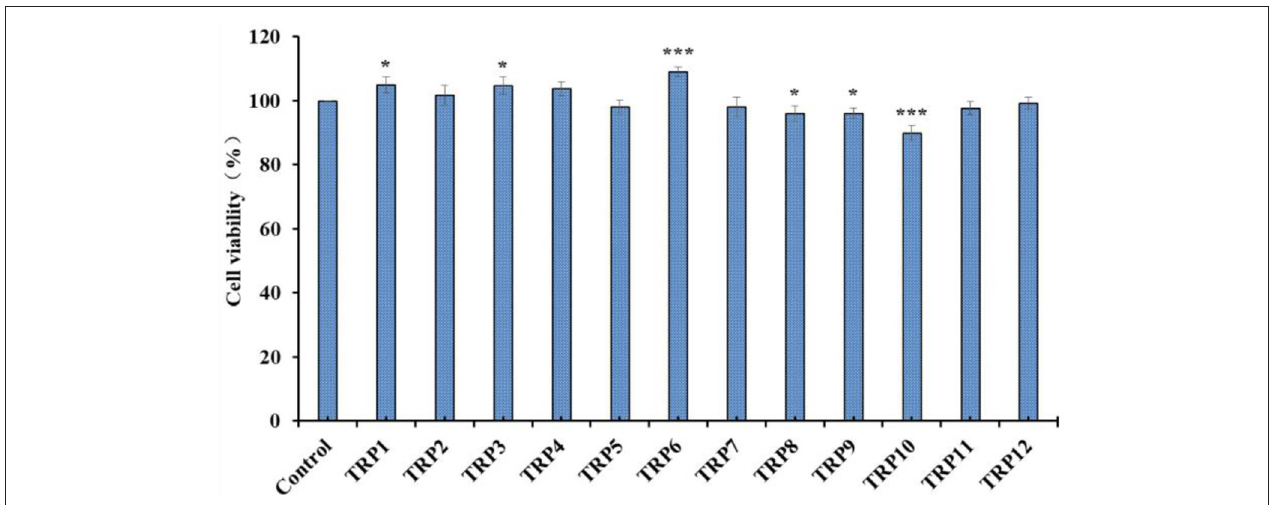
FIGURE 8 | Effects of 12 isolated APs (TRP1 to TRP12) on the viability of Chang liver cells. All data are presented as the mean ± SD ( n = 3). * p < 0.05 and *** p < 0.001 vs. model group.